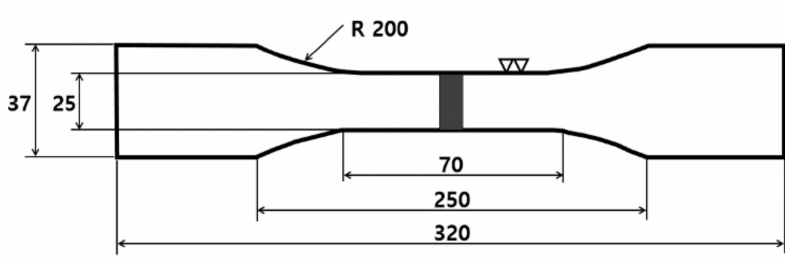
Figure 5. Butt-weld fatigue specimen, thickness 10 mm.